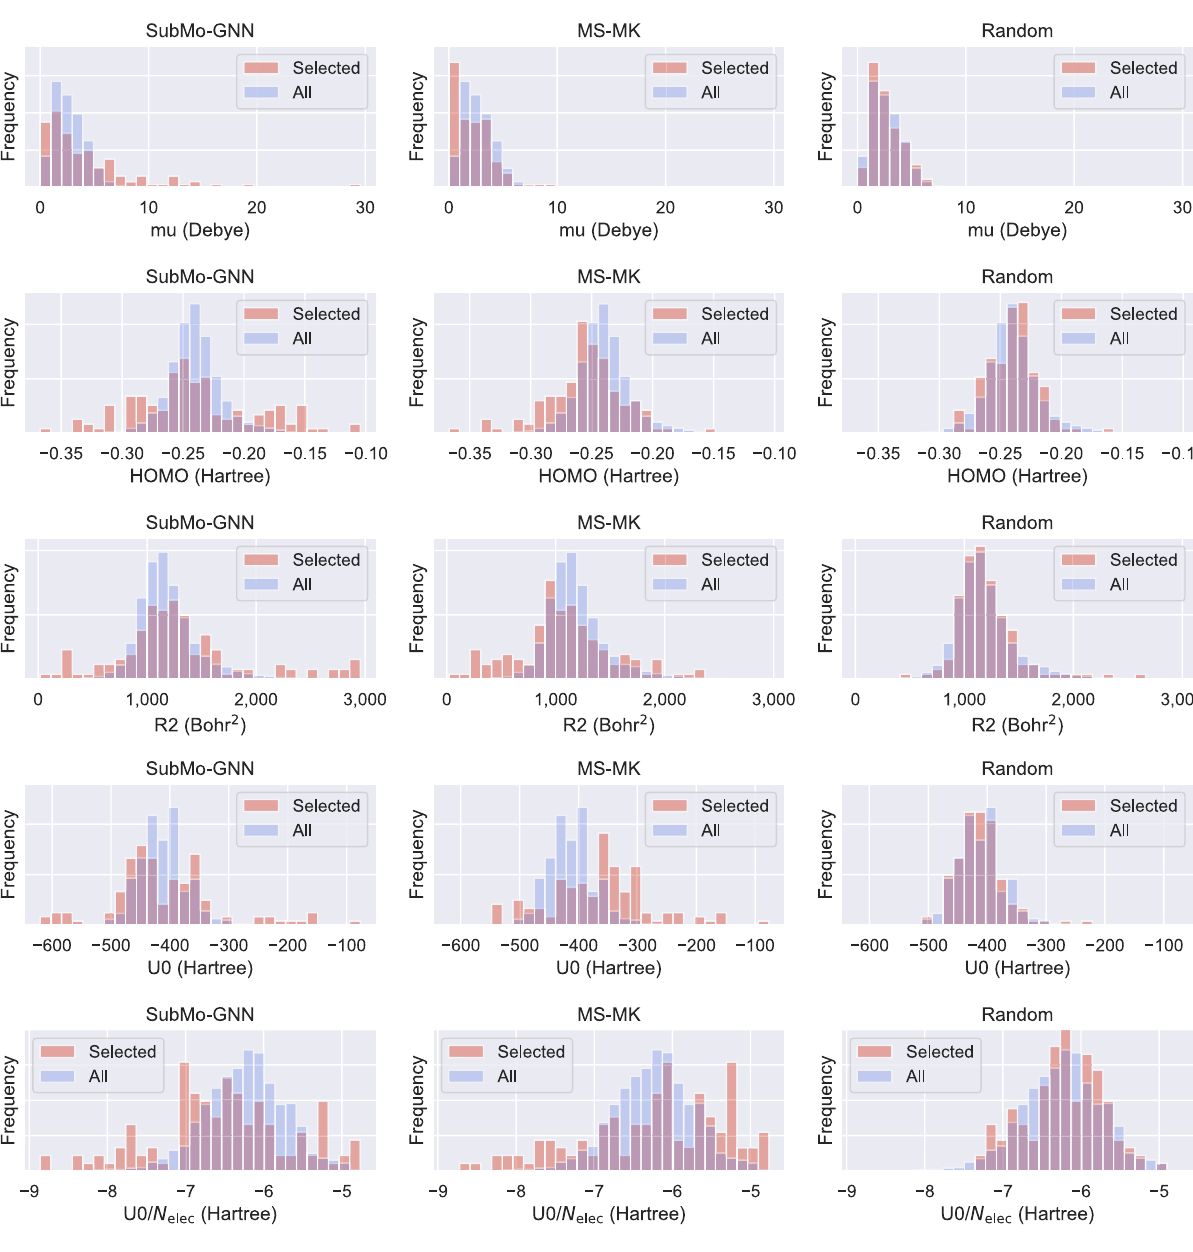
Figure 5. Property-value distributions of selected molecules (red) and all molecules in the test dataset (blue). The horizontal axis indicates property values, which are partitioned into 30 bins. We let the height show the probability density for ease of comparison. Results of the same property and method are aligned in a row and a column, respectively.